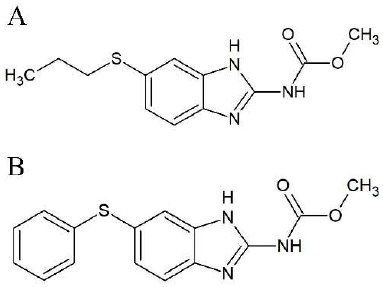
Figure 1. Chemical structures of ( A ) albendazole and ( B ) fenbendazole.